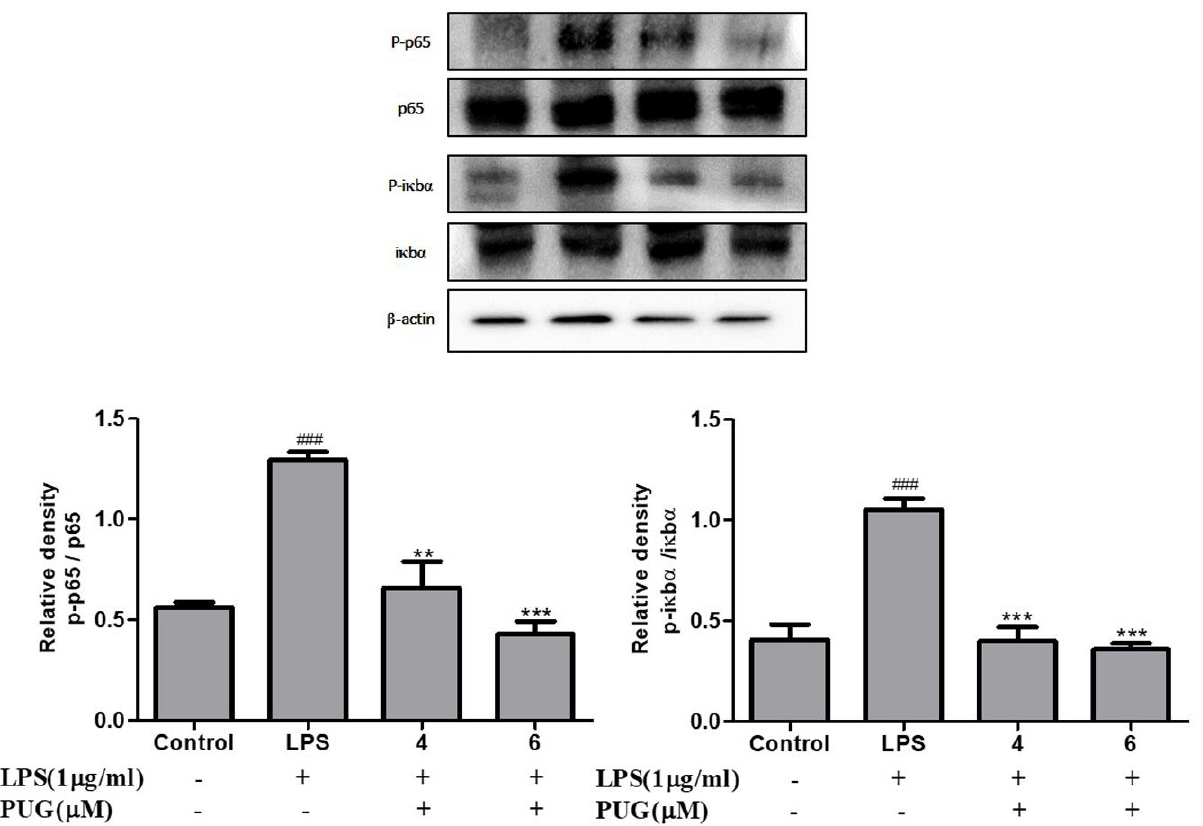
Figure 7. PUG inhibits the NF- κ B pathway in LPS-stimulated RAW264.7 cells: Western blot analysis of the NF- κ B pathway proteins. After the treatment with LPS and PUG, the protein was isolated from the cells and Western blotting was performed. The expression levels were calculated by the densitometry with the SEM of three independent values. The relative density was calculated with the total form and phospho forms of the protein. The statistical significance was ### p < 0.001 vs. untreated group; and ** p < 0.01, *** p < 0.001 vs. LPS-alone treated group.